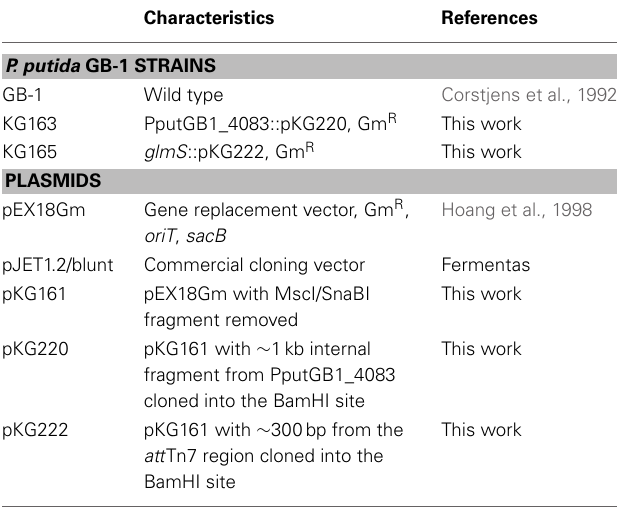
Table 1 | Bacterial strains and plasmids used in genetic studies in this